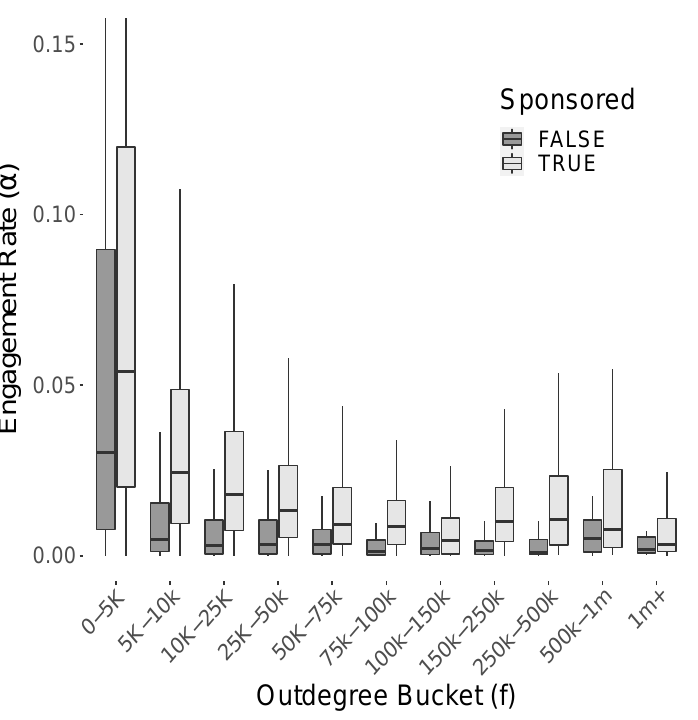
Figure 1. Engagement Levels as a Function of Out-Degree